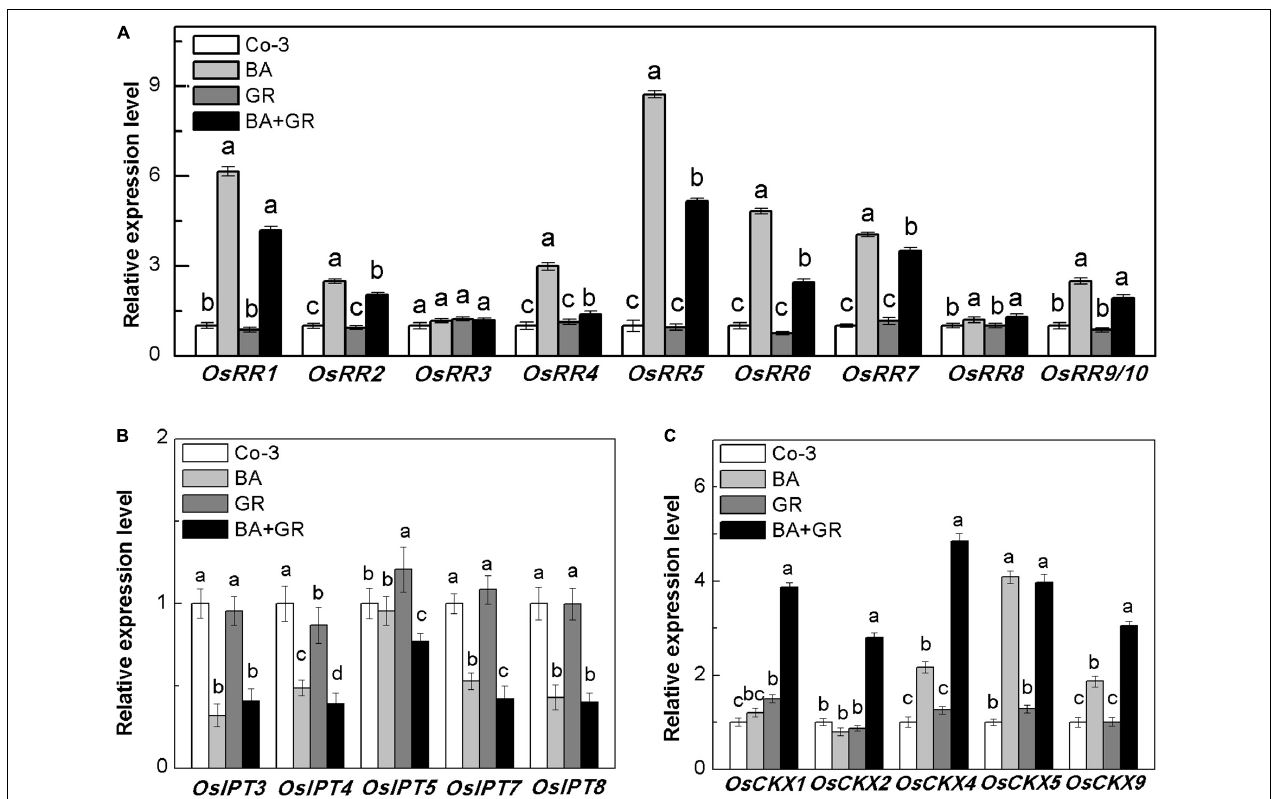
FIGURE 8 | Effect of GR or/and BA treatments on CK-related gene expression in axillary buds at node 2 at full heading stage. (A) Cytokinin-type-A RR genes expression, (B) five isopentenyl transferase genes expression, and (C) five cytokinin oxidase/dehydrogenase genes expression. The axillary bud at node 2 was treated for 12 h with or without BA (40 µ M) or/and rac-GR (2 µ M). The expression of each gene in the bud at node 2 is represented relative to Co-3. Total RNA was isolated from less than 0.1 g of buds and nodes each time. β -Actin was used as a reference gene. The value obtained from the control treatment at 0 h after treatment was arbitrarily set at 1.0. Quantitative real-time PCR was performed in triplicate (three biological replicates), and mean values with SD are